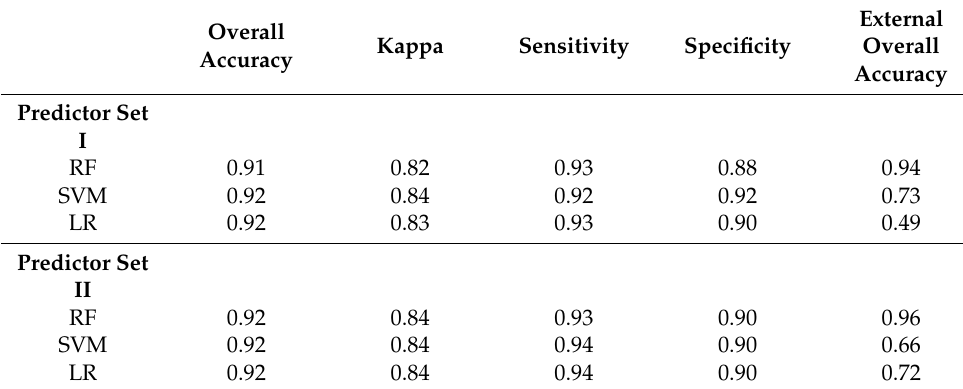
Table 6. Accuracy metrics of all models with both predictor sets.